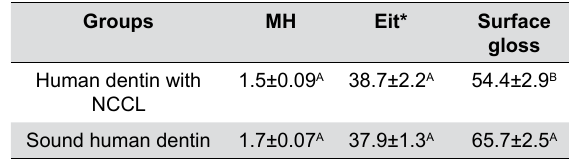
Table 1- Means and standard deviations of MH (GPa), Eit* (GPa) and surface gloss (GU) of sound and NCCL human dentin